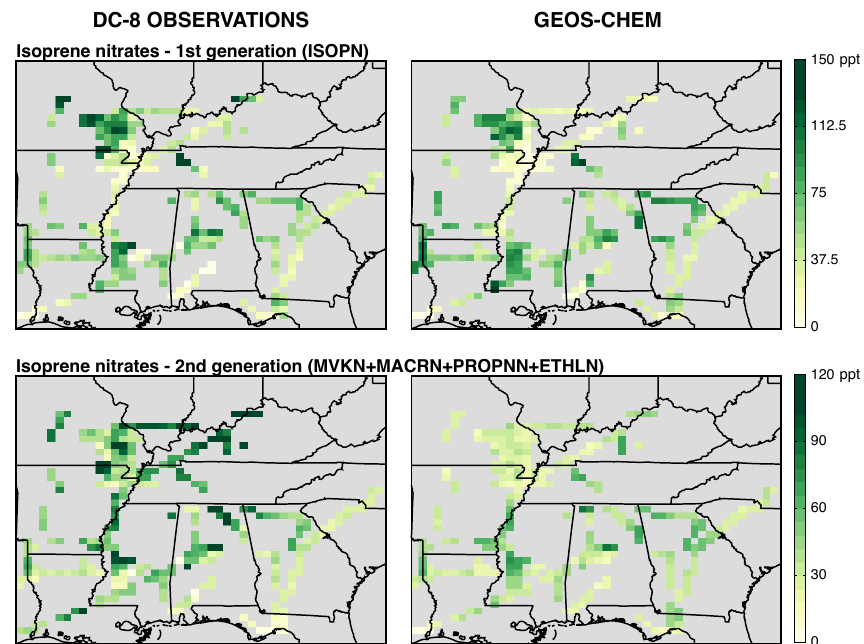
Figure 7. Observed (left) and simulated (right) mixing ratios of isoprene nitrates below 1km during SEAC 4 RS, separated into first generation (ISOPN) and second generation (MVKN+MACRN+PROPNN+ETHLN) species. The GEOS-Chem simulation has been sampled along the aircraft flight tracks, and the observations binned to the spatial and temporal resolution of the model, as described in the text. The normalized mean bias of the simulation relative to the measurements in the lowest 500m is − 0.6% for ISOPN and − 35% for second generation isoprene